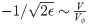
A graph depicting -1/2ϵ∼VVϕ as a function of the inflaton ϕ for two fifth-order polynomial models, and a sixth-order polynomial model.For a fifth-order polynomial model with r = 0.001 (Blue line) the CMB window width is ∼8 e-folds, while the field changes by about Δϕ ∼ 0.1. Most of the e-folds are generated when ϕ reaches ∼0.4. When r is increased the CMB window widens, and approaches the e-fold generating peak (Red dots). While marginally affecting the CMB window width, the introduction of an additional coefficient, a6, allows to shift the peak to higher values of ϕ, thereby decoupling the CMB window and the e-fold generating peak (Green dash).